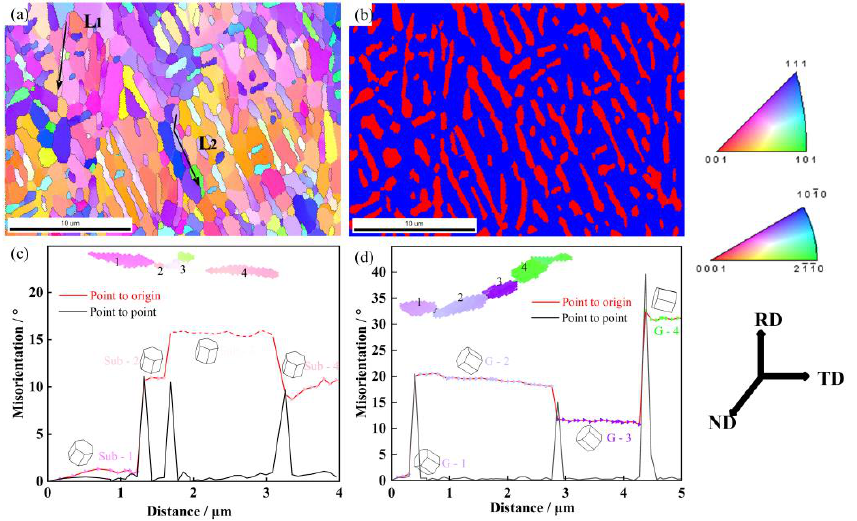
Figure 9. EBSD result of Ti-55511 alloy deformed to a strain of 0.83 and annealed for 30 min at 775 °C: ( a ) IPF map, ( b ) phase map. Misorientation change along ( c ) L 1 ; ( d ) L 2 .